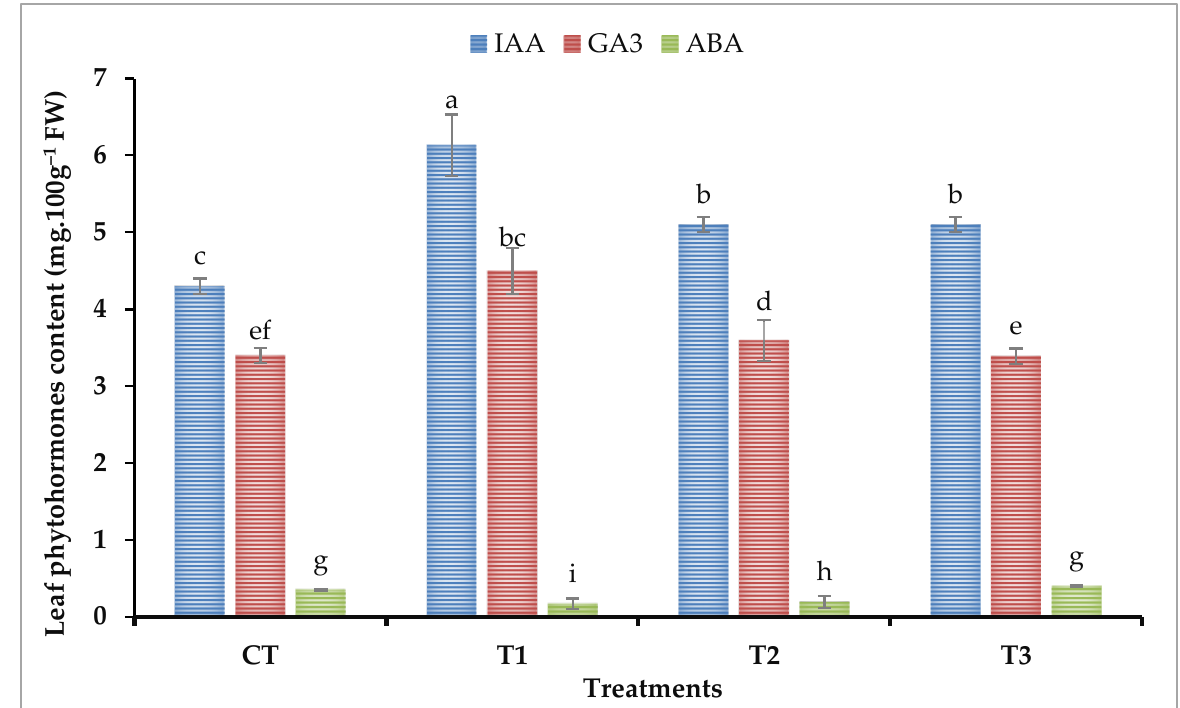
Figure 1. Impact of diverse iron sources, as foliar spray, on Leaf phytohormonal content of Vicia faba plants. Means of each column followed by the same letter are not statistically different according to the Duncan multiple comparison test at the 5% level. Each value is the average of 6 replicates over two seasons. Bars indicated to standard error ( ± SE). T1 = Synthesized nano-iron, T2 = Chelated iron, T3 = Iron sulfate, and CT = Control. FW = fresh weight.